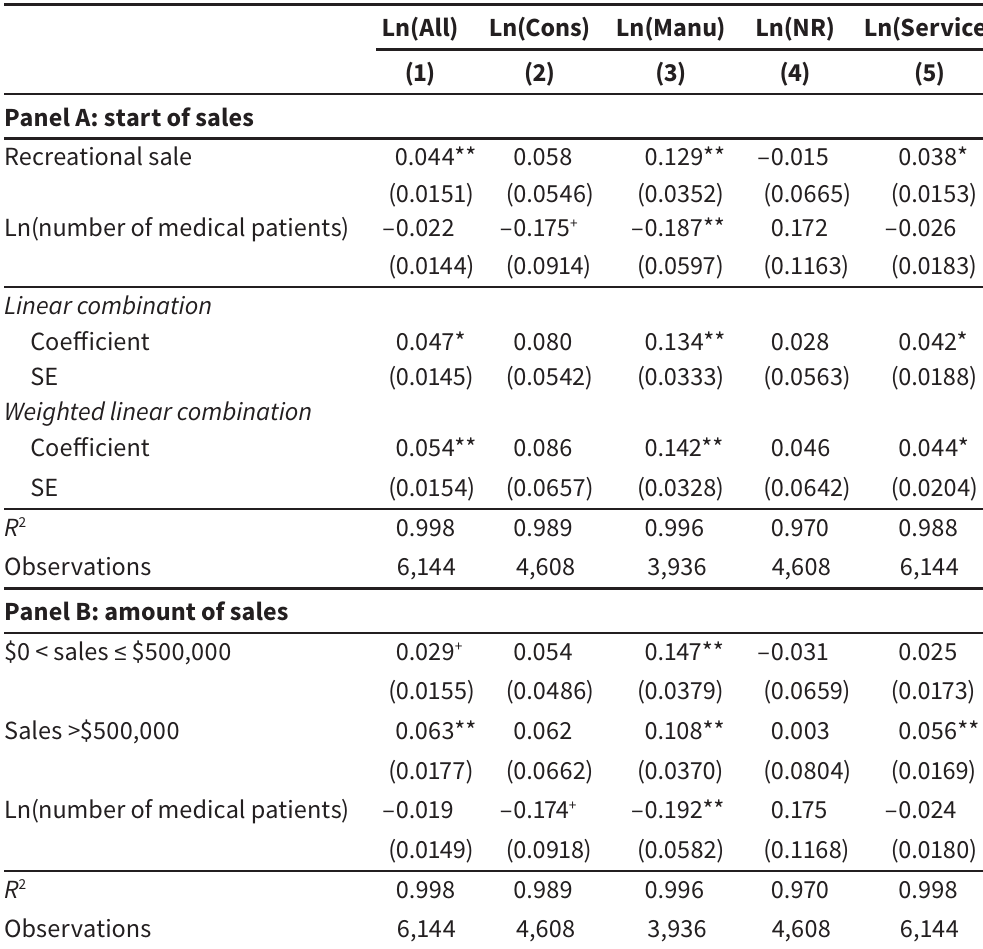
The effect of recreational dispensary entry and sales on employment –